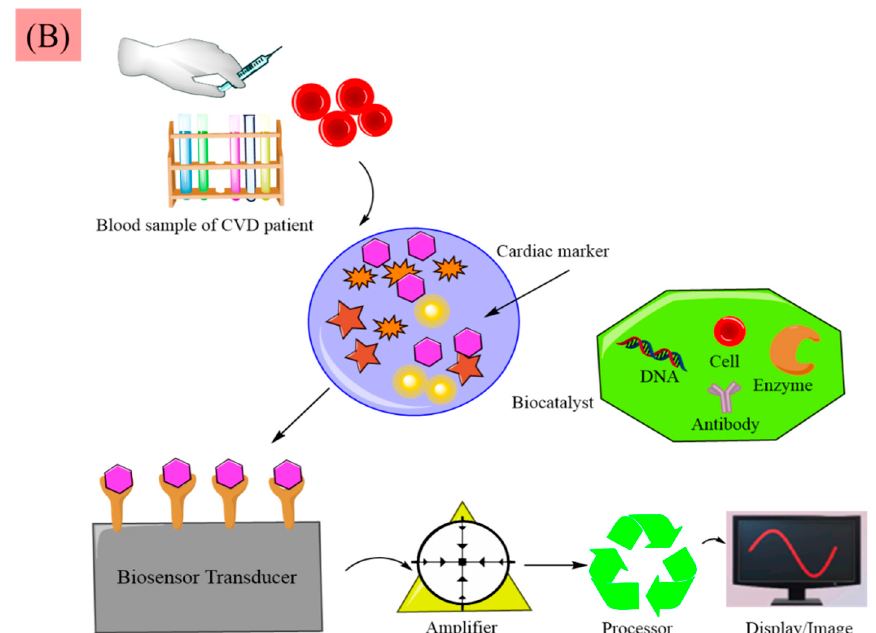
Figure 9. Mechanisms of nanodiagnosis, imaging, and nanotreatment of CVDs. ( A ) Mechanistic nanocarrier-based approach for the diagnosis and treatment of cardiomyocytes in CVDs with enhanced sensitivity against the cardiobiomarker. ( B ) Application of the biosensor approach to detect cardiac markers in CVD patients’ blood where the sensor uses biocatalysts such as DNA, enzymes, cell, antibody to detect specific cardiobiomarkers.